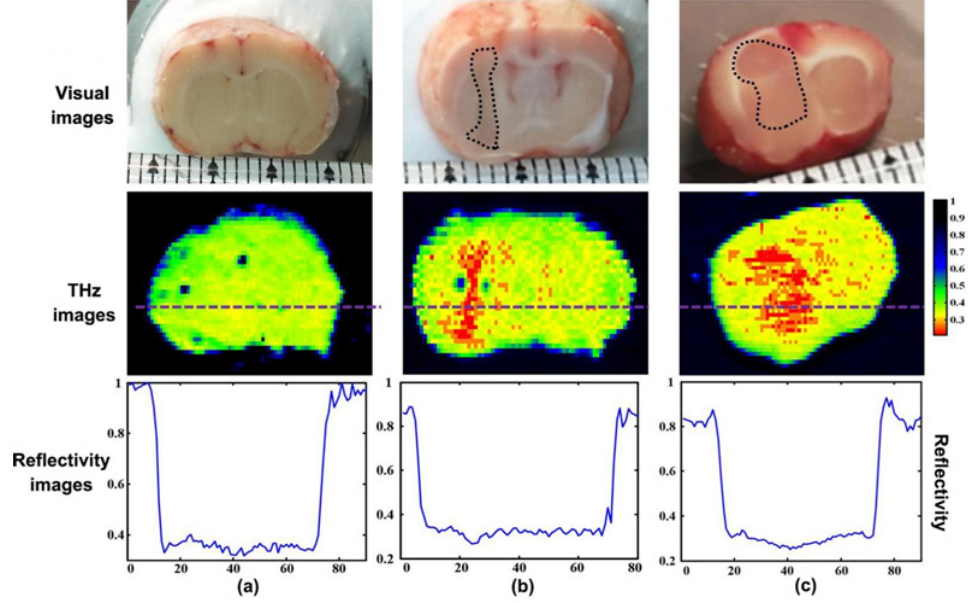
Figure 6. Visual imaging, THz imaging, and the reflectivity at the horizontal purple line of THz images of freshly excised